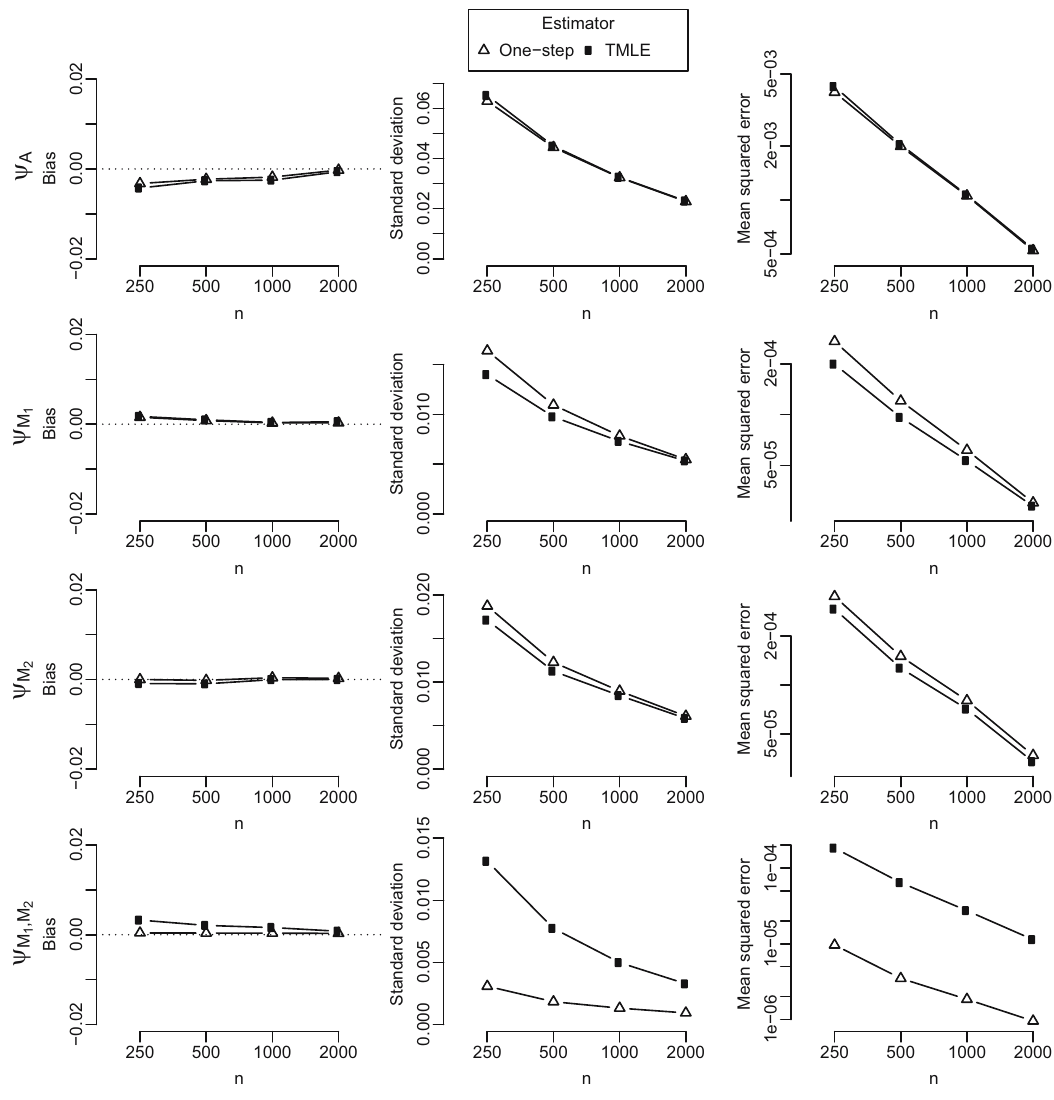
Figure 2: Comparison of one - step and TMLEs in terms of their Monte Carlo - estimated bias, standard deviation, and mean ) , indirect ( squared - error for the interventional direct ( ψ A